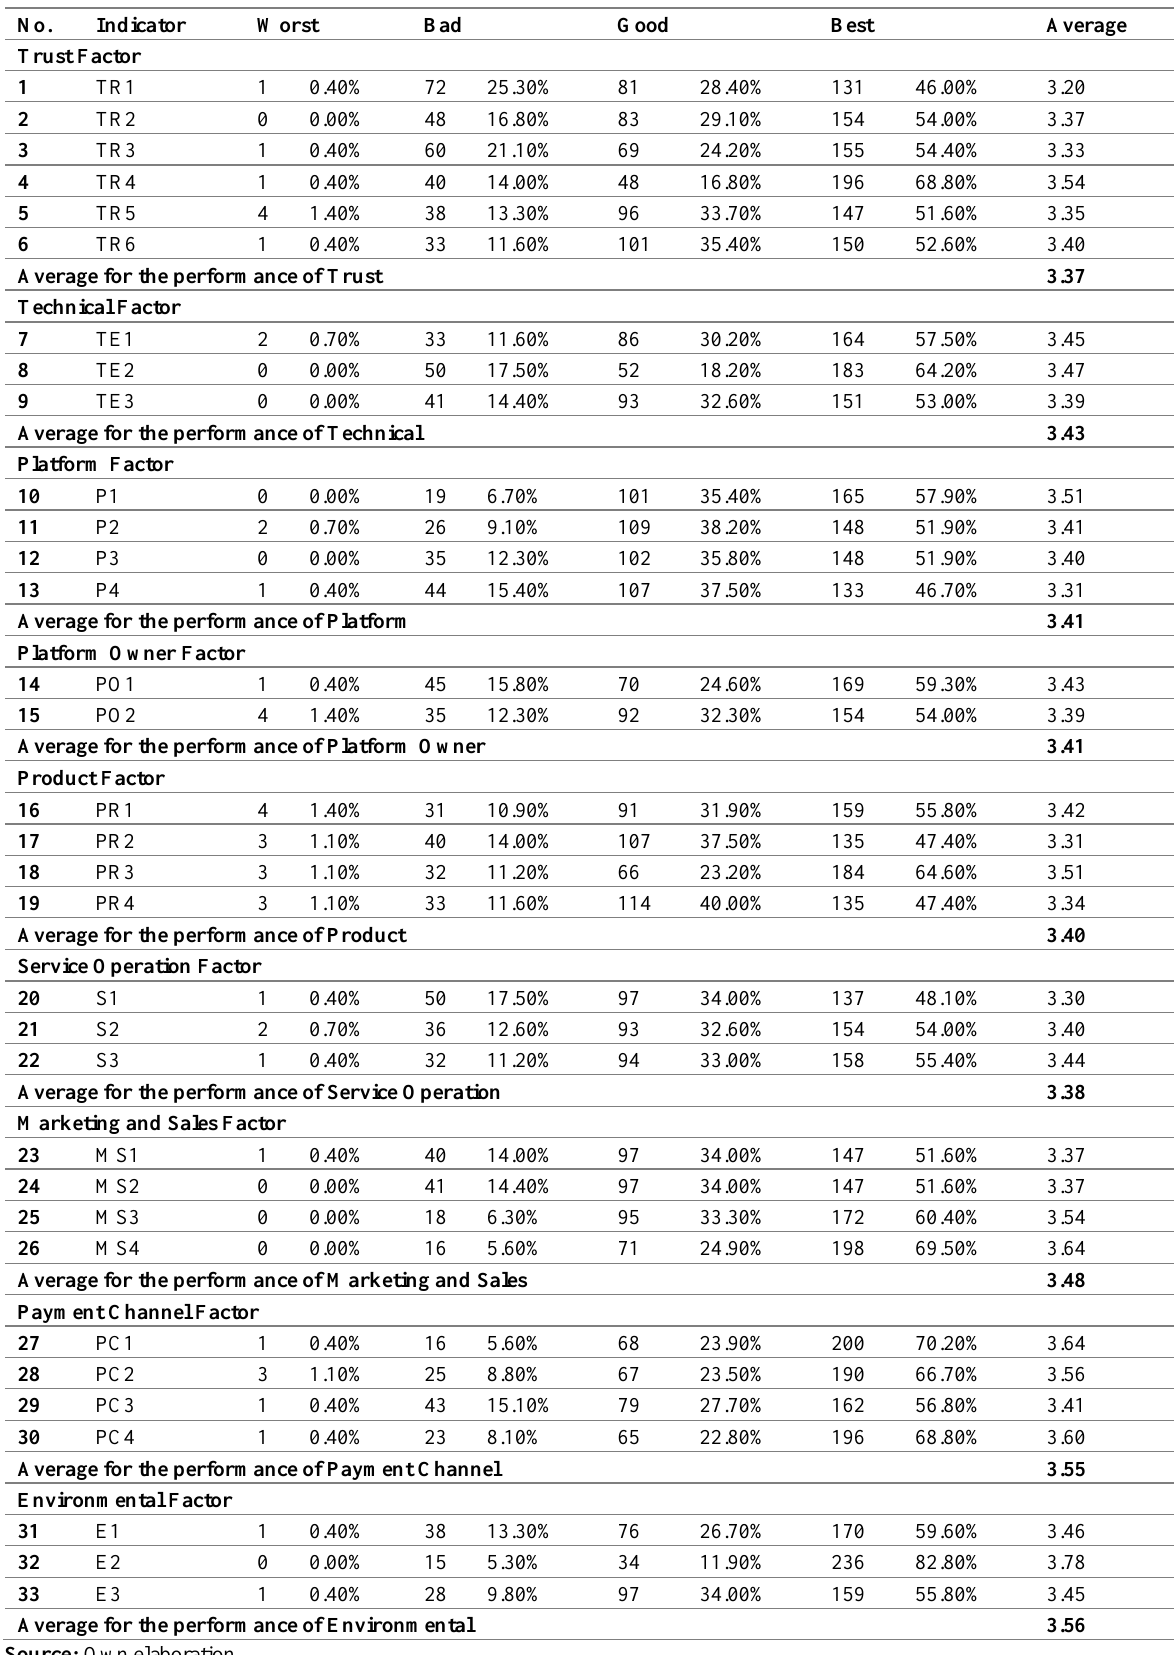
Table 3 : Responses and Average of the Performance